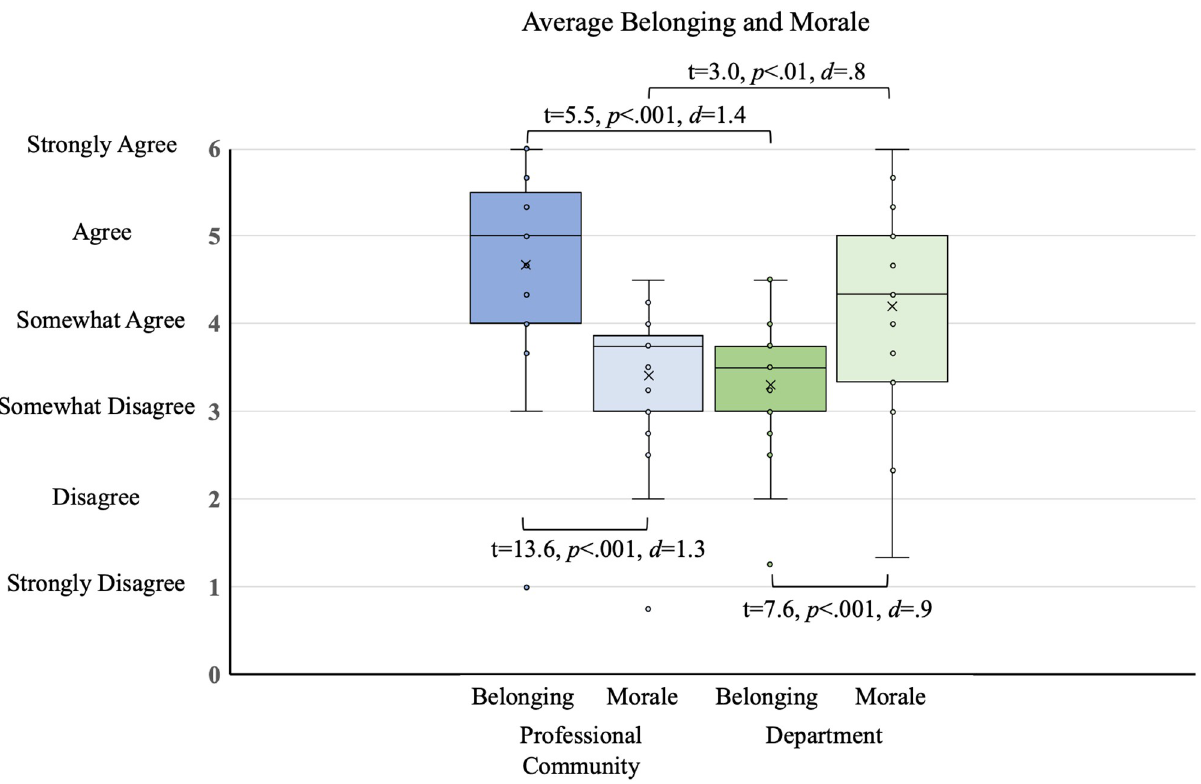
Fig 1. Sense of belonging and morale in a professional community (blue) and department (green). ‘X’ indicates the average.